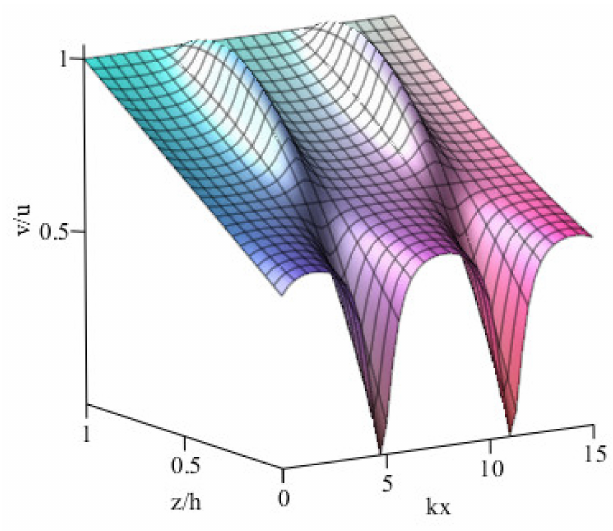
Figure 1. The relative tangential velocity v x / u at di ff erent height z / h for b / h = 1 + sin( kx